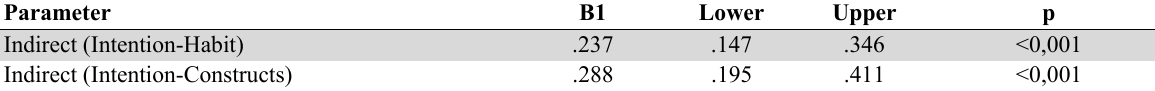
Statistical Data on Indirect Effect of Habit and Social Commerce Constructs on Purchase Intention Parameter B1 Lower Upper p Indirect (Intention-Habit) .237 Indirect (Intention-Constructs) .288 .195 .411